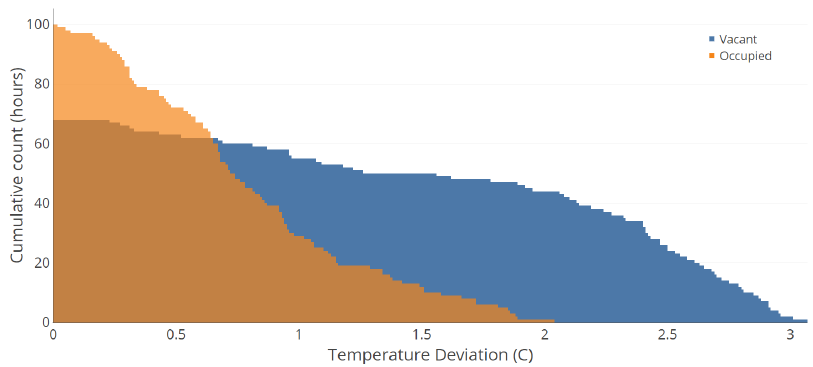
Figure 15. Case 2B duration curve of deviation from 24.5 ◦ C operative